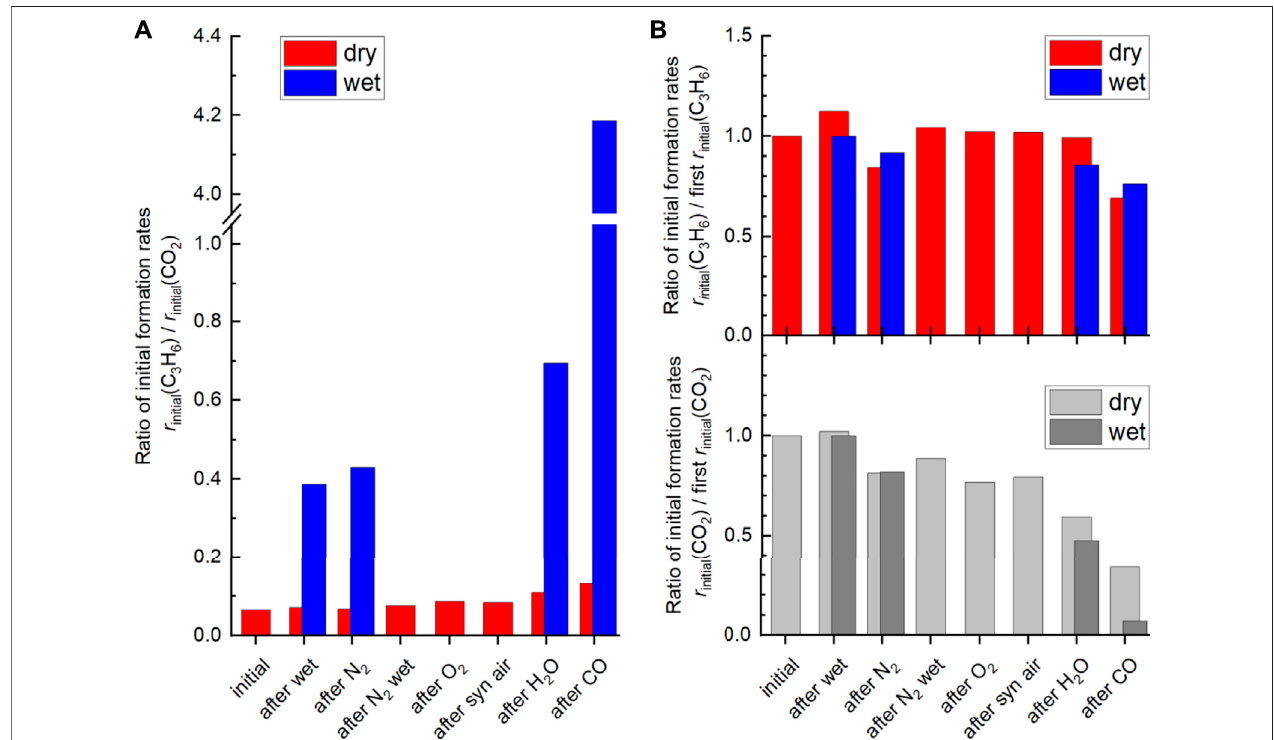
FIGURE12|(A) RatioofinitialpropeneformationrateandCO 2 formationrateindryfeed(red)andwetfeed(blue). (B) Ratioofinitialpropene(C 3 H 6 )formationrates (r initial (C 3 H 6 )) after the different treatments and initial propene formation rate at the beginning of the experiment (condition: initial in dry feed (red) and in wet feed (blue) on thetop.TheratioofinitialCO 2 formationratesafterthedifferenttreatmentsandinitialCO 2 formationrate(r initial (CO 2 ))atthebeginningoftheexperiment(condition:initialin dryfeed(lightgrey)and wet feed(dark grey)onthebottom. Dataobtainedfrom contact time variationat 300 ° C. Contacttime(W/F) ranges from0.00347 g · min · L − 1 to 0.00947 g · min · L − 1 in dry feed (C 3 H 8 /O 2 /inert (cid:2) 5/10/85) and wet feed (C 3 H 8 /O 2 /inert/H 2 O (cid:2)